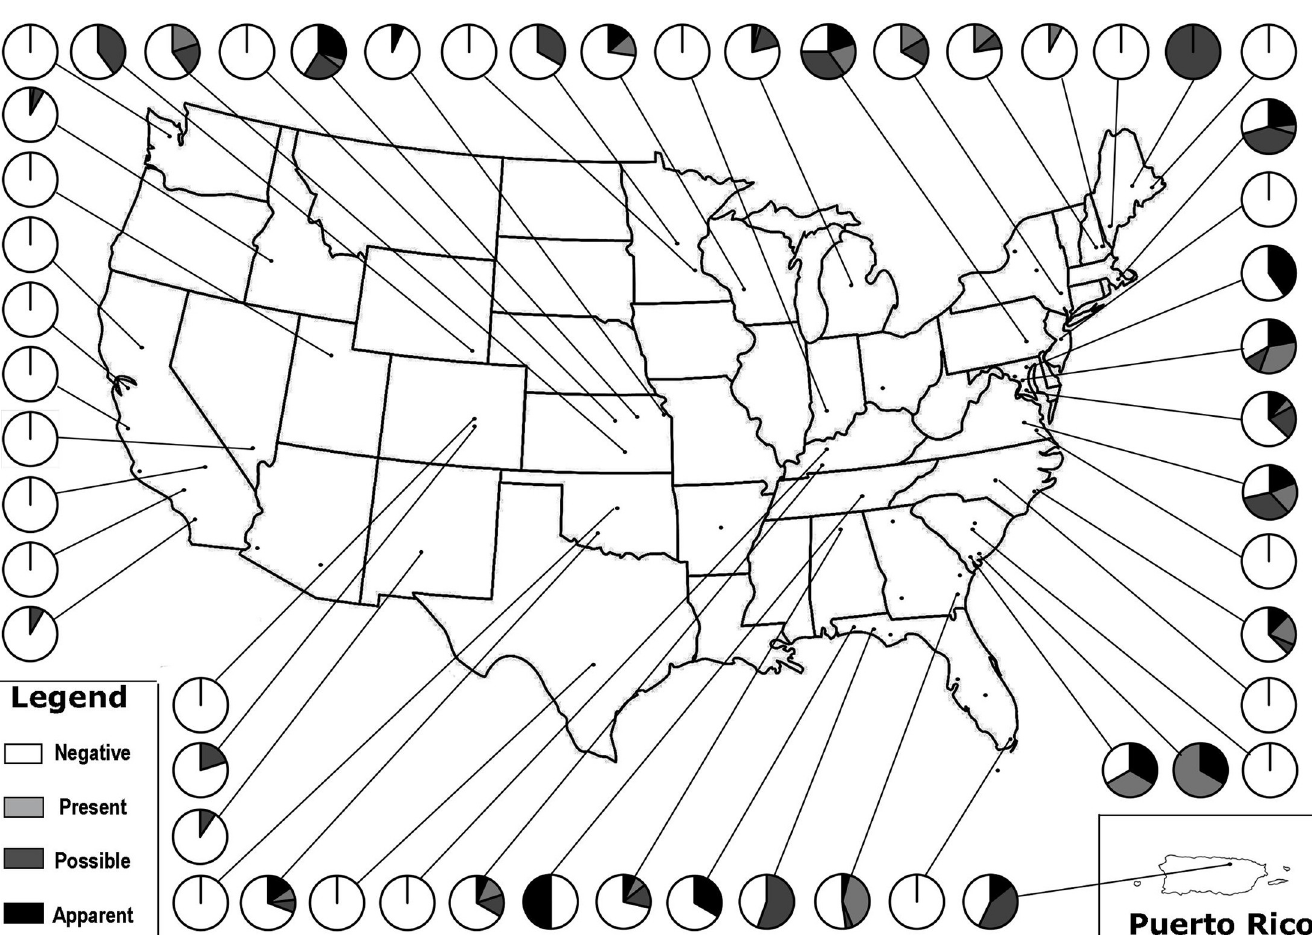
Fig 2. Spatial distribution and prevalence of ophidiomycosis in snakes on military installations sampled in 2018. Negative = no clinical signs and no qPCR detection of Ophidiomyces ophiodiicola ; ( Ophidiomyces ) Present = qPCR positive AND no clinical signs; Possible (ophidiomycosis) = clinical signs present AND no qPCR detection; Apparent (ophidiomycosis) = qPCR detection AND clinical signs.